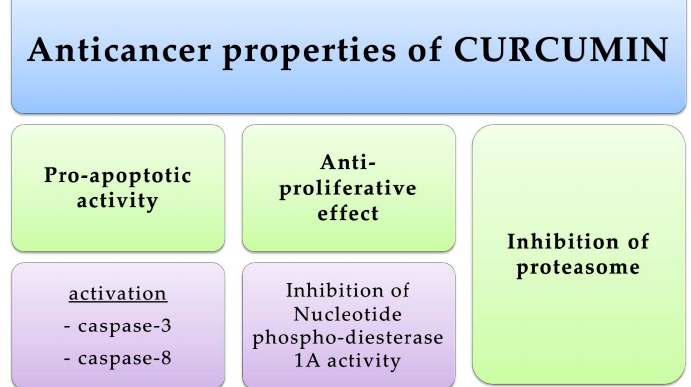
Figure 7. Anticancer properties of curcumin. The green fields indicate the properties of